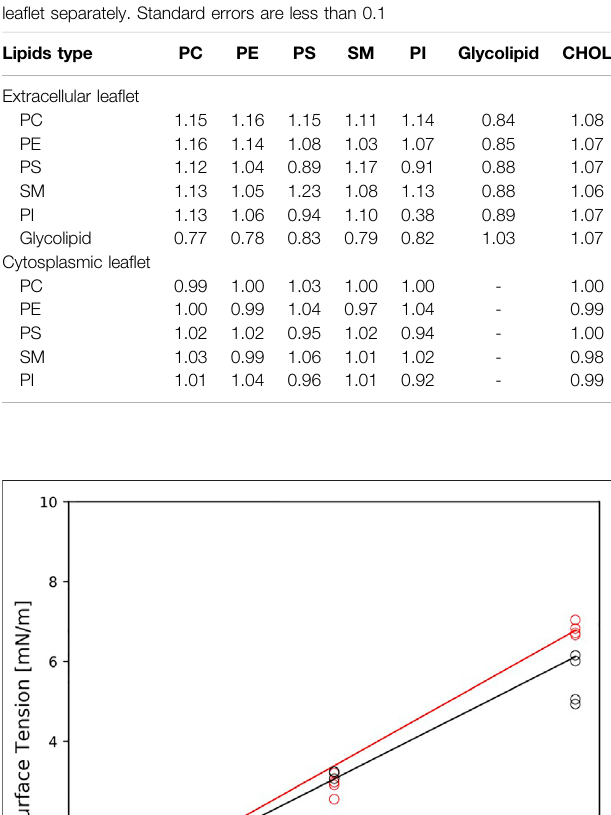
Frontiers in Molecular Biosciences |